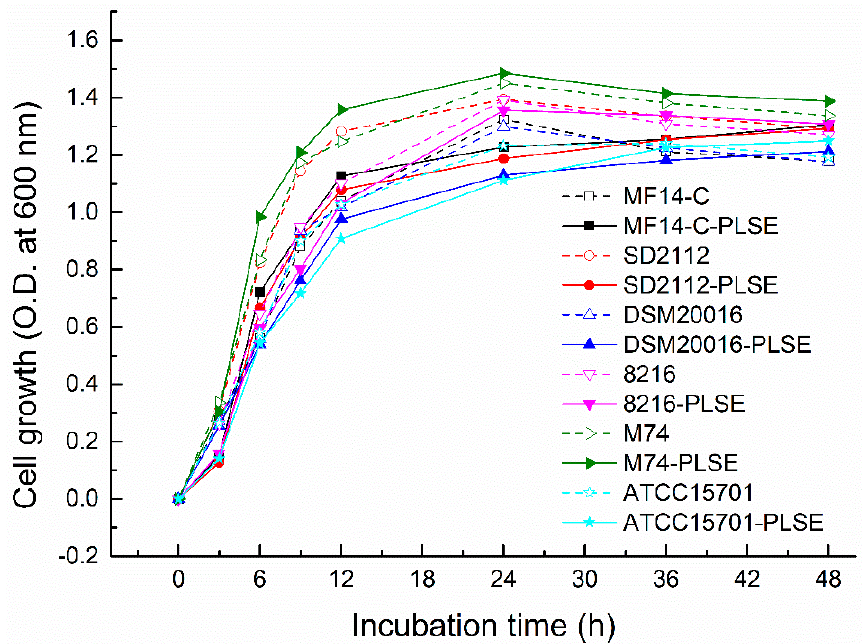
Figure 1. The cell growth of six strains of probiotic bacteria in De Man, Rogosa and Sharpe (MRS) broth (with or without polyphenols from lotus seed epicarp (PLSE)) for 48 h at 37 °C.